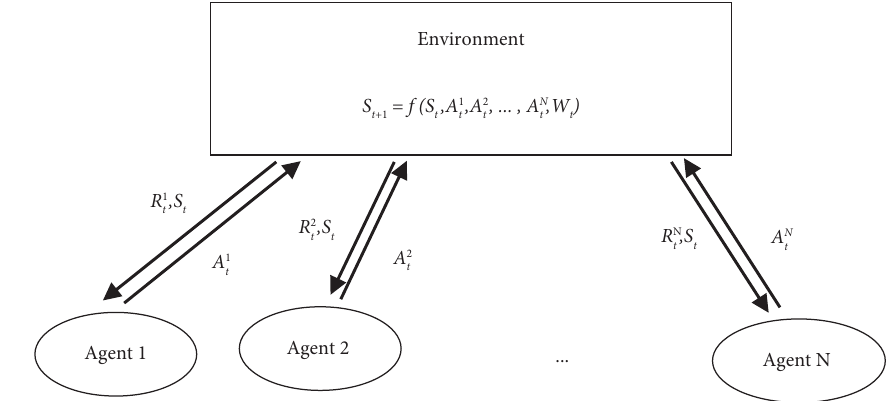
Figure 2: Te structure of decentralized control � s, A i � a i ]) : t − 1 1